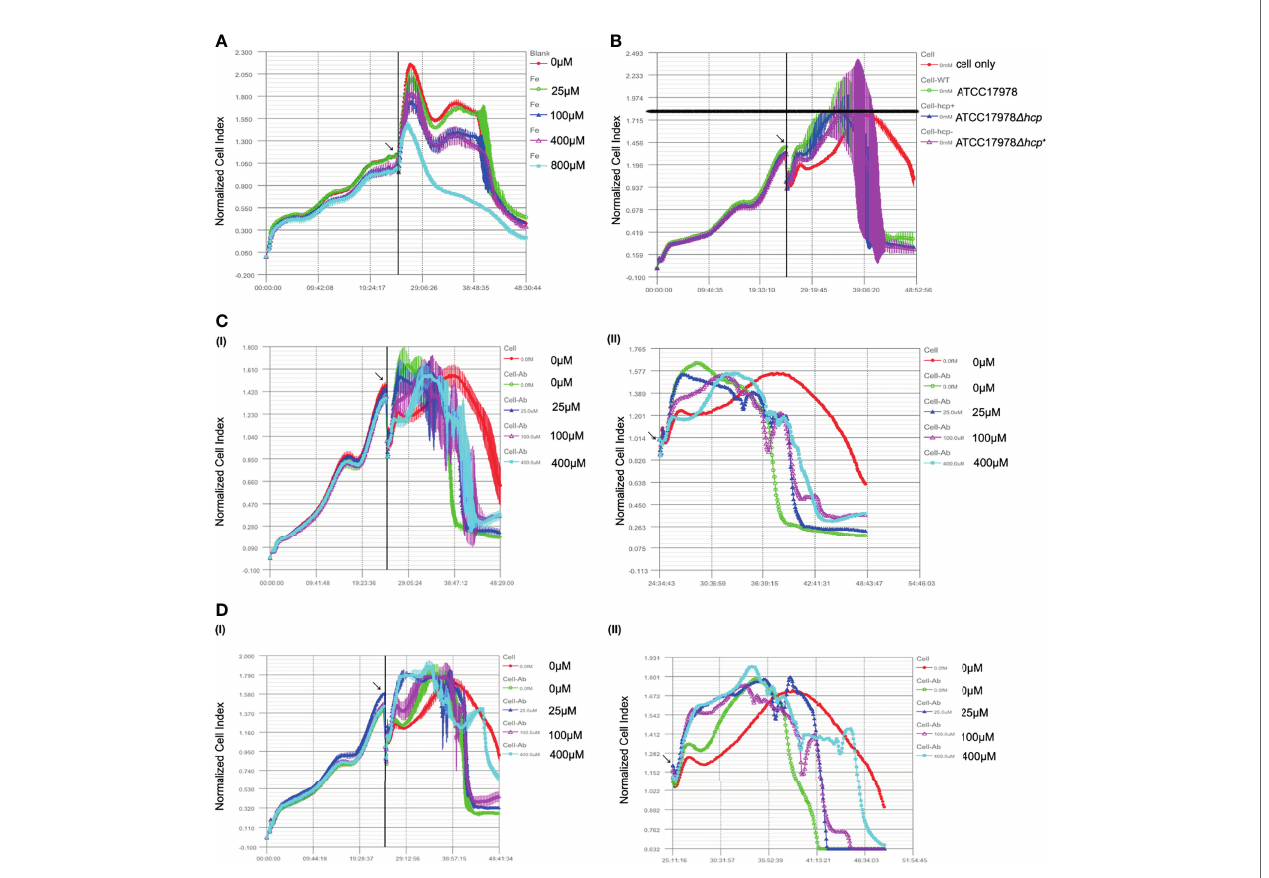
FIGURE 2 | Effect of hcp or iron ions on the interaction between Acinetobacter baumannii and human alveolar epithelial cells. (A) Effect of different concentrations of iron ions on human pulmonary alveolar epithelial cells (HPAEpiC) growth. Cells grew well, and little difference is observed among the groups when the iron ions were less than 400 m M, while the peak normalized cell index (NCI) of the 800 m M group was the lowest. Thus, 0 (iron deprivation), 25, 100, and 400 m M were suitable for subsequent bacteria cells ’ co-culture studies. (B) Effect of ATCC17978, ATCC17978 D hcp , and ATCC17978 D hcp + on HPAEpiC growth. As bacteria were added into culture, an increase of NCI was induced as compared to the control group (cell only). Meanwhile, the peak NCI of experimental groups appeared earlier than that of the control group. However, the peak value among the groups was similar. [ (C) (I, II) ] Effect of iron ions on the cell growth index in the co-culture of the ATCC17978 strain and the cells. Initial bacteria-induced increase in NCI and an advanced peak as compared to the control group. The 0 m M (iron deprivation), 25 m M, 100 m M, and 400 m M iron ion groups had similar curves. The lower iron ion concentration was the earliest peak. [ (D) (I, II) ] Effect of iron ions on the cell growth index in the co-culture of ATCC17978 D hcp and the cells. Similar to panel [ (C (I, II) ], the initial bacterial infection induced an increase in NCI and an early peak. The curve of the 0 m M iron ion (iron deprivation) group declined faster, and there was no signi fi cant difference among experimental groups in the peak value. Contrary to panel [ (C) (I, I) ], the 0 m M, 25 m M, 100 m M, and 400 m M iron ion groups had similar